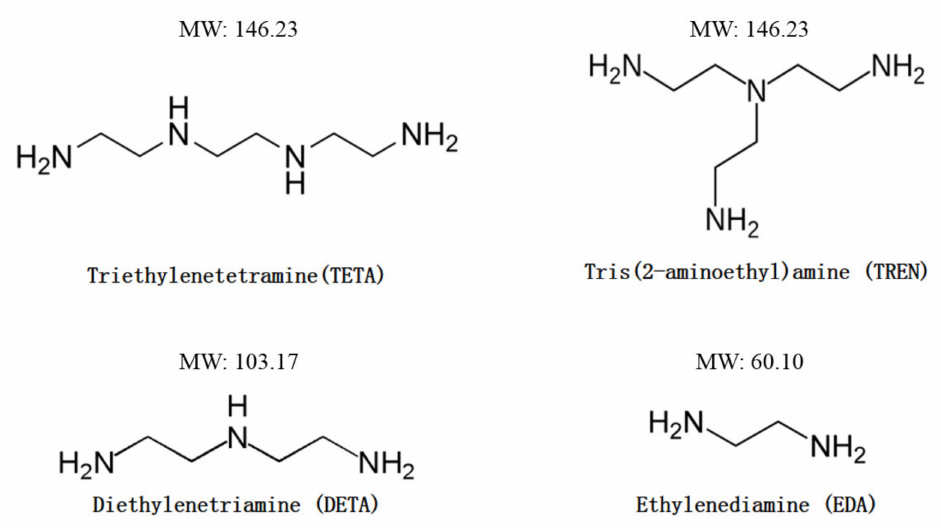
Figure 1. Structures of four different aliphatic amine curing agents used in this